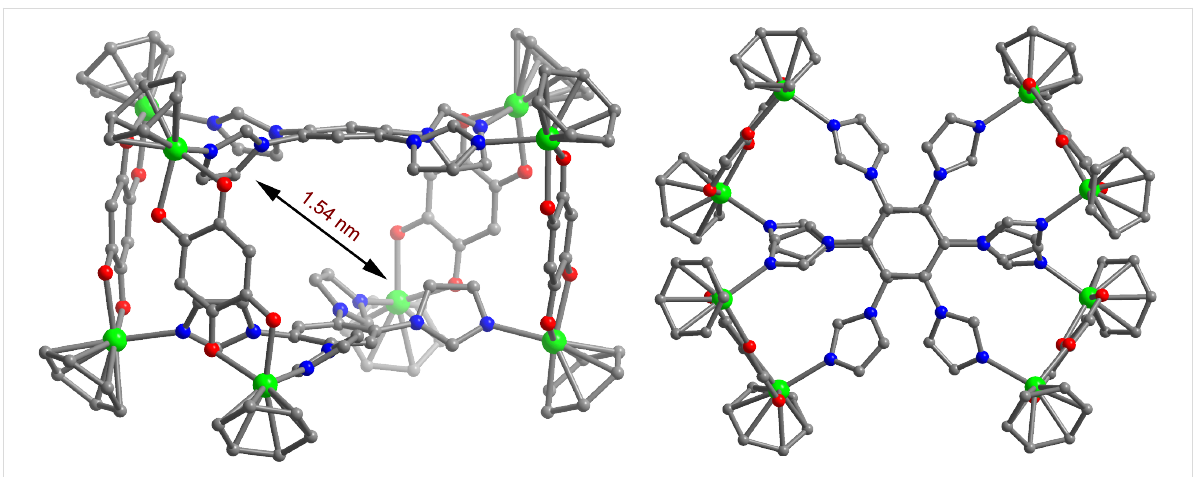
Figure 5: Side (left) and top (right) view of the energy-minimized structures of the octanuclear macrocycle 2c . Color code: green = Ru, blue = N, red = O, gray = C. The hydrogen atoms, methyl and isopropyl group of the cymene moiety have been removed for the sake of clarity.